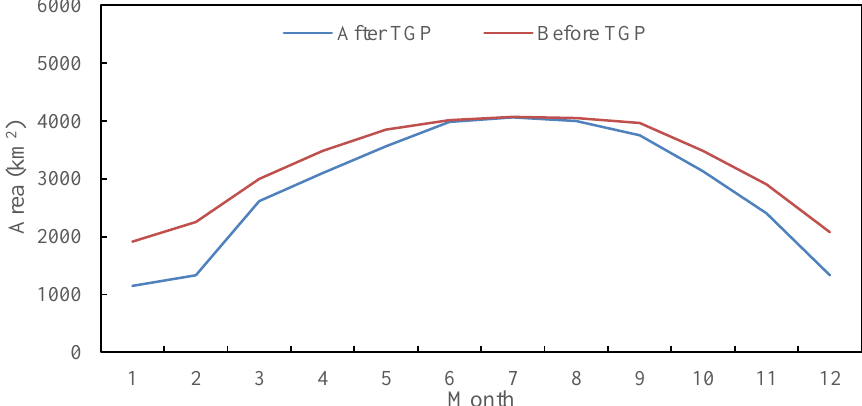
Figure 14. The monthly area variations of Poyang Lake before (red) and after (blue) the TGP.